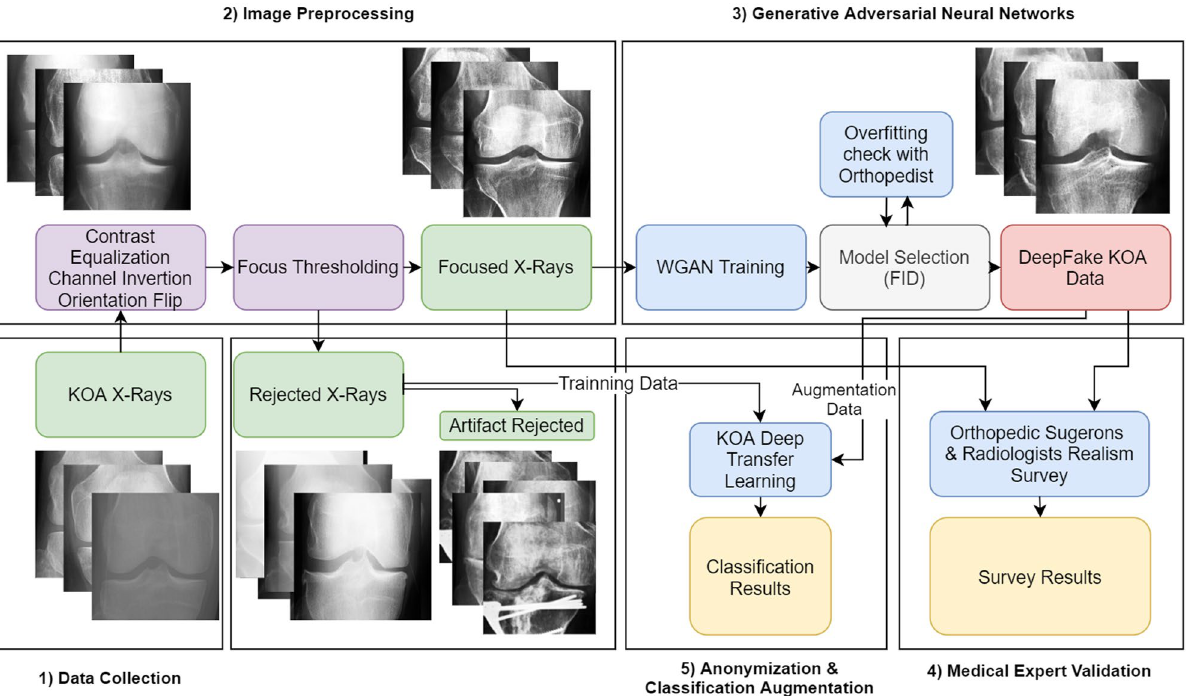
Figure 5. Flowchart of tasks and data involved in this paper. Real data are highlighted in green; DeepFake data are in red. Purple signifies data processing operations, and blue indicates classification-related procedures. Block headers contain ascending numbers to signify the order of operations (from 1 to 5).